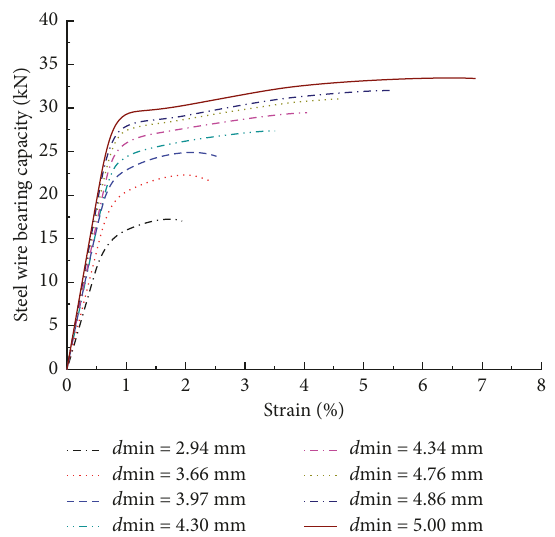
Figure 3: Bearing capacity-strain curve of damaged steel